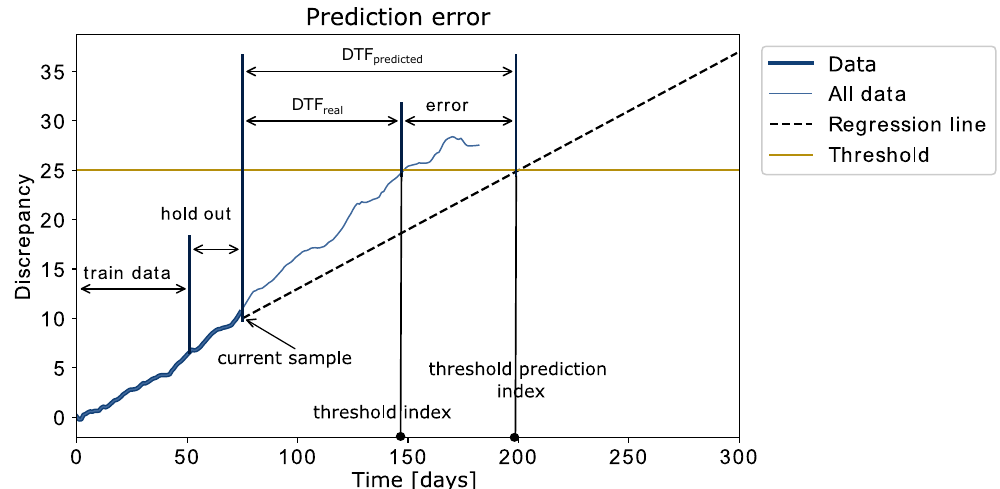
Figure 5. Explanatory figure of the prediction error